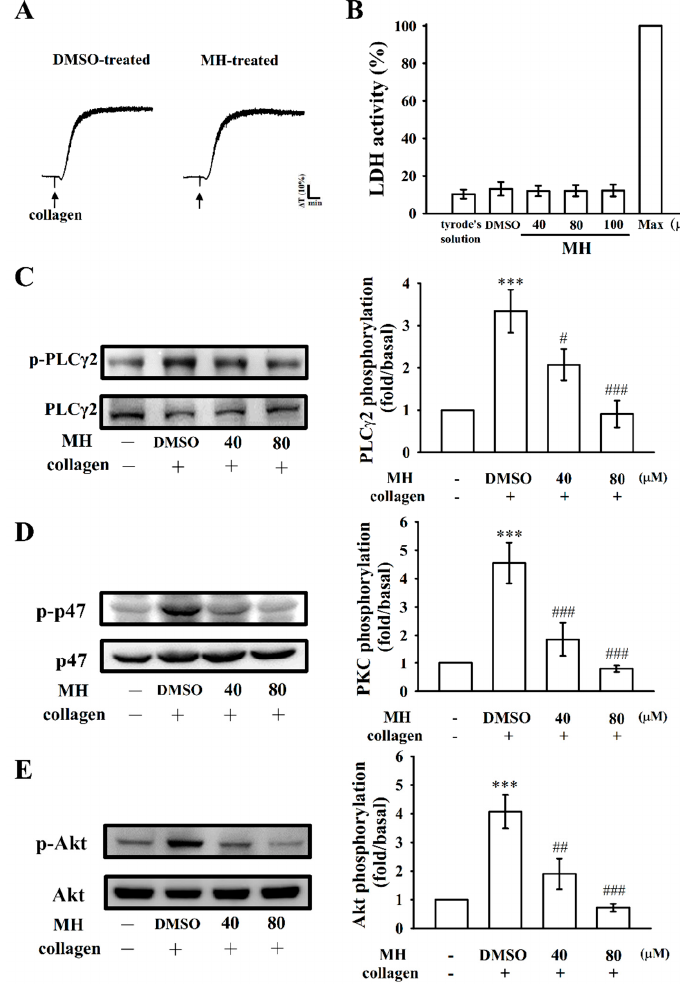
Figure 3. Effects of morin hydrate on cytotoxicity, lactate dehydrogenase (LDH) release, and PLC γ 2, PKC, and Akt activation in human platelets. ( A ) Washed platelets (3.6 × 10 8 cells/mL) were preincubated with the solvent control (0.1% DMSO) or morin hydrate (100 μ M) for 10 min and consequently washed twice with Tyrode’s solution; collagen (1 μ g/mL) was then added to trigger platelet aggregation; ( B ) washed platelets were preincubated with the solvent control (0.1% DMSO) or morin hydrate (40, 80, and 100 µ M) for 20 min and a 10- µ L aliquot of the supernatant was deposited on a Fuji Dri-Chem slide LDH-PIII, as described in Materials and Methods. ( C – E ) For the other experiments, washed platelets were preincubated with the solvent control (0.1% DMSO) or morin hydrate (40 and 80 µ M) and subsequently treated with collagen (1 µ g/mL) to induce ( C ) PLC γ 2 and ( D ) PKC activation (p47, pleckstrin phosphorylation) and ( E ) Akt phosphorylation. Data are presented as means ± standard errors of means ( n = 4). *** p < 0.001 compared with the resting control; # p < 0.05, ## p < 0.01, and ### p < 0.001 compared with the DMSO-treated